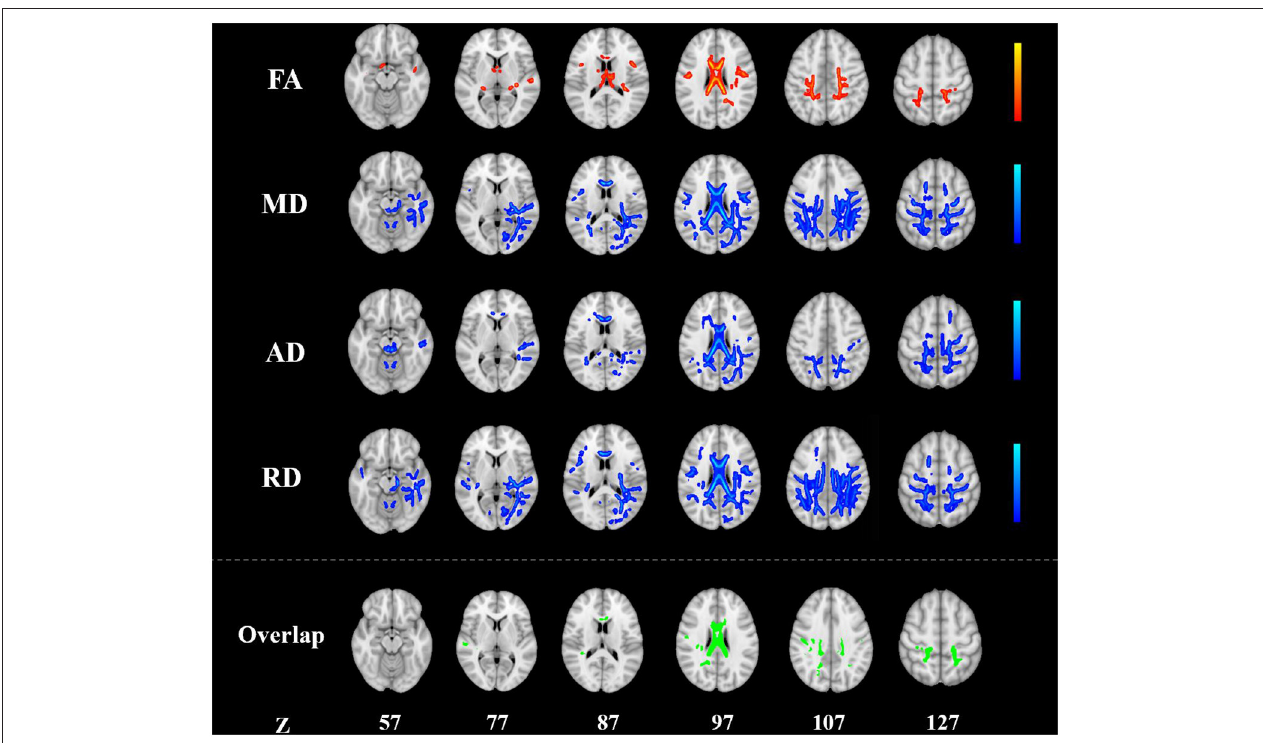
FIGURE 1 | Alterations in TBSS parameters in patients with KOA. White matter regions showing increased FA and decreased MD, AD, and RD values in patients with KOA compared to healthy controls. White matter regions showing overlapping FA, MD, AD, and RD values in the body, the splenium of the corpus callosum ( p < 0.05, TFCE corrected). AD, radial diffusivity; FA, fractional anisotropy; KOA, knee osteoarthritis; MD, mean diffusivity; RD, radial diffusivity; TBSS, tract-based spatial statistics; TFCE, threshold-free cluster enhancement.